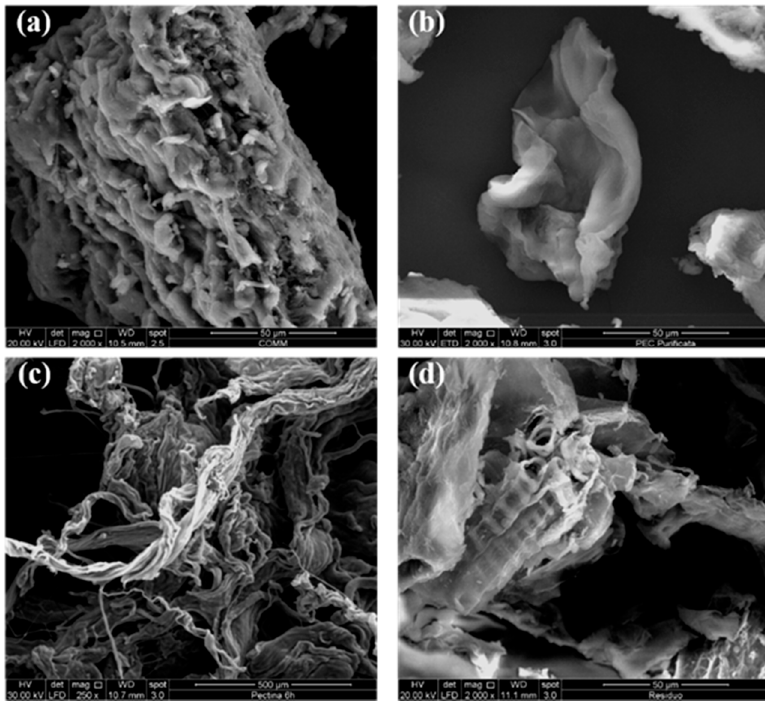
Figure 6. SEM micrographs of commercial pectin ( a ), purified PEC ( b ), PEC-6h-3% ( c ), and residue ( d